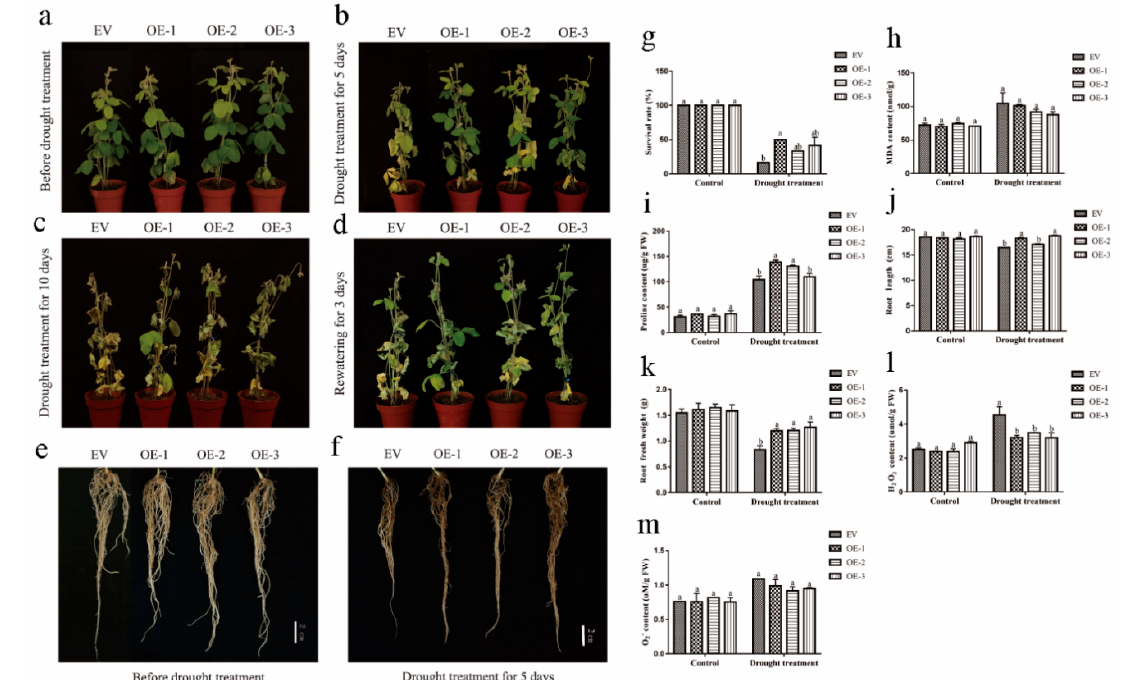
Figure 6. Phenotypic analysis of GmEF4 -overexpressing ( GmEF4 -OE) and empty vector (EV)-control plants under drought treatment. ( a ) and ( b , c ) Phenotypes of GmEF4 -OE and EV-control transgenic soybean plants under normal and drought conditions. ( d ) Phenotypes of GmEF4 -OE and EV-control transgenic soybean plants under rewatering conditions. ( e ) and ( f ) Phenotypes of GmEF4 -OE and EV-control hairy roots under normal and drought conditions. ( g ) Survival of normal and drought-stressed plants. ( h ) Malondialdehyde (MDA) content and ( i ) proline content of GmEF4 -OE and EV-control plants grown with drought treatment. ( j ) the root length, ( k ) total fresh weight, ( l ) H 2 O 2 content, and ( m ) O 2 − content of GmEF4 -OE and EV-control soybean hairy roots grown with drought treatment. The di ff erent letters in the bar graphs indicate significant di ff erences at p < 0.05 between GmEF4 -OE and EV-control transgenic soybean.